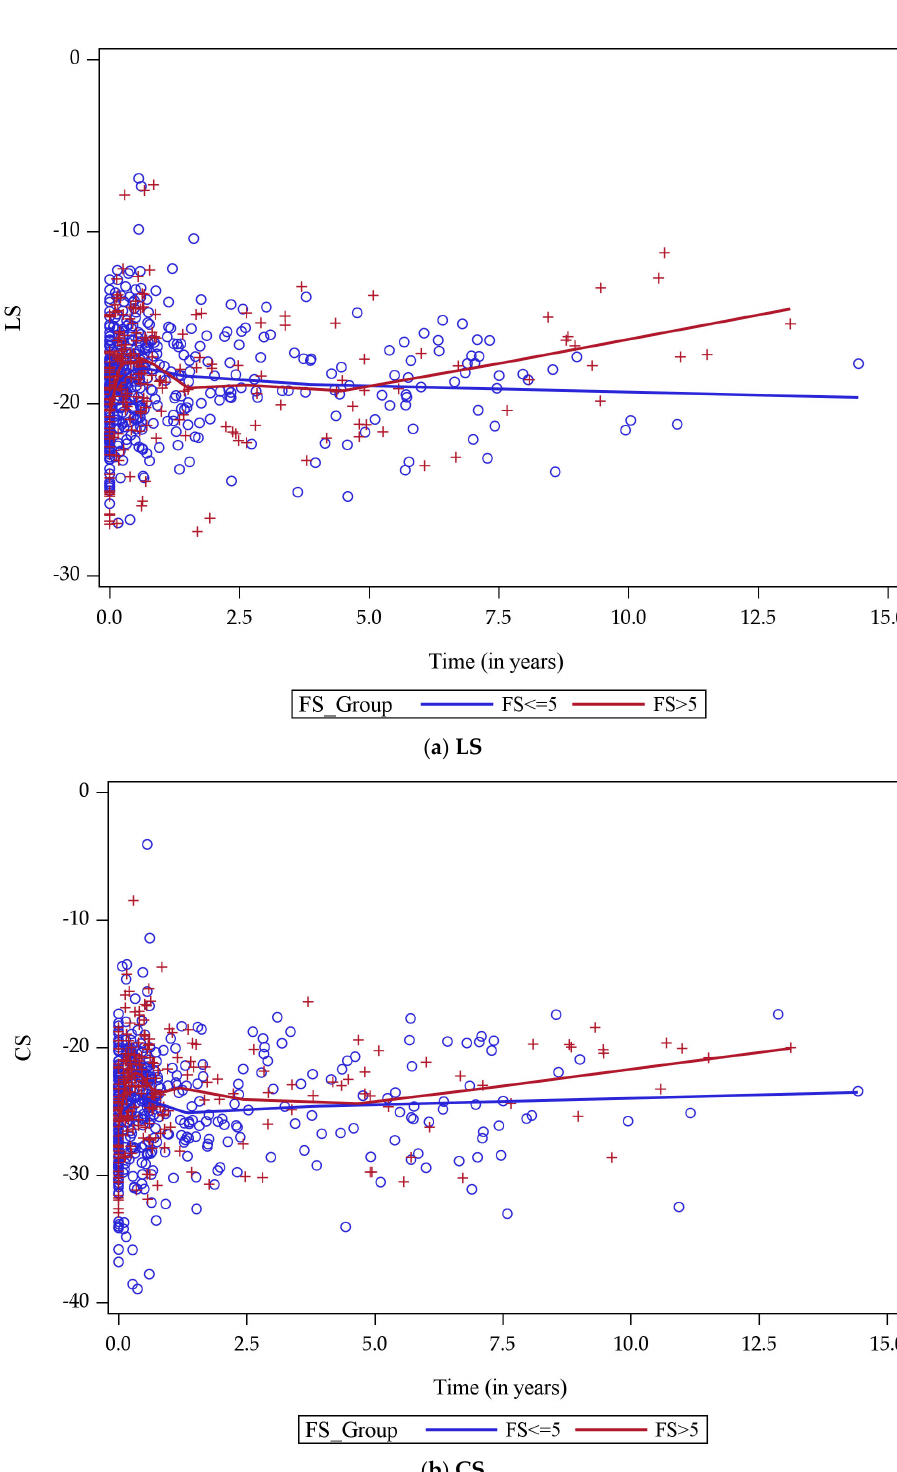
Figure 2. ( a , b ) Trends in longitudinal and circumferential strain over time. Longitudinal strain (LS) ( a ) and Circumferential strain (CS) ( b ) plotted over time among individuals who experienced a decline in fractional shortening (FS) from pre-treatment to the most recent echocardiogram by >5 FS unit (red) and those who did not (blue) indicates a difference in rate of change in LS and CS about five years after a cancer diagnosis. Separate Loess smoothers are applied to each group to visually demonstrate the longitudinal trends. +/ ◦ Indicate individual strain